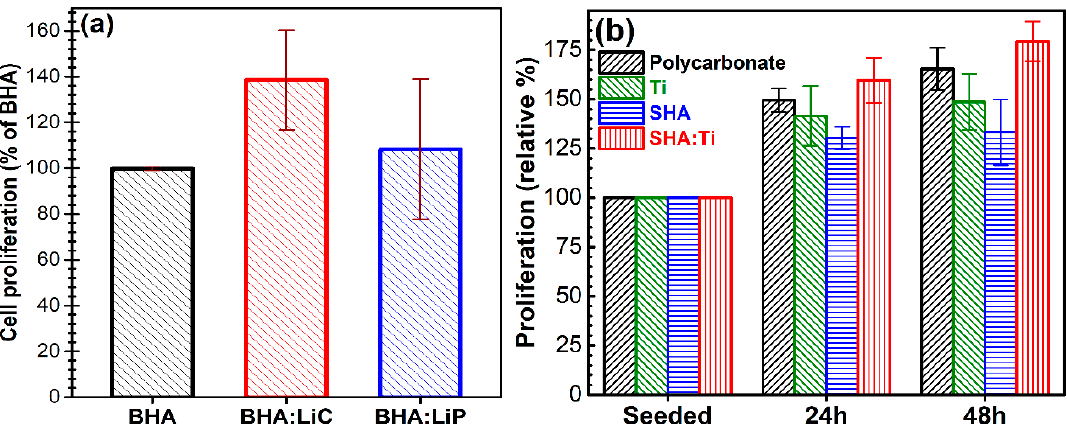
Figure 7. Proliferation of human mesenchymal stem cells assessed by MTS assay in the case of ( a ) bovine hydroxyapatite (BHA) and doped BHA coatings and ( b ) Ti, sheep hydroxyapatite (SHA), and doped SHA coatings synthesized by PLD. Reprinted from References [25,60], with permission from Elsevier. Slight modifications of the acronyms from the original figures were done to be in agreement with the sample codes used in this review.